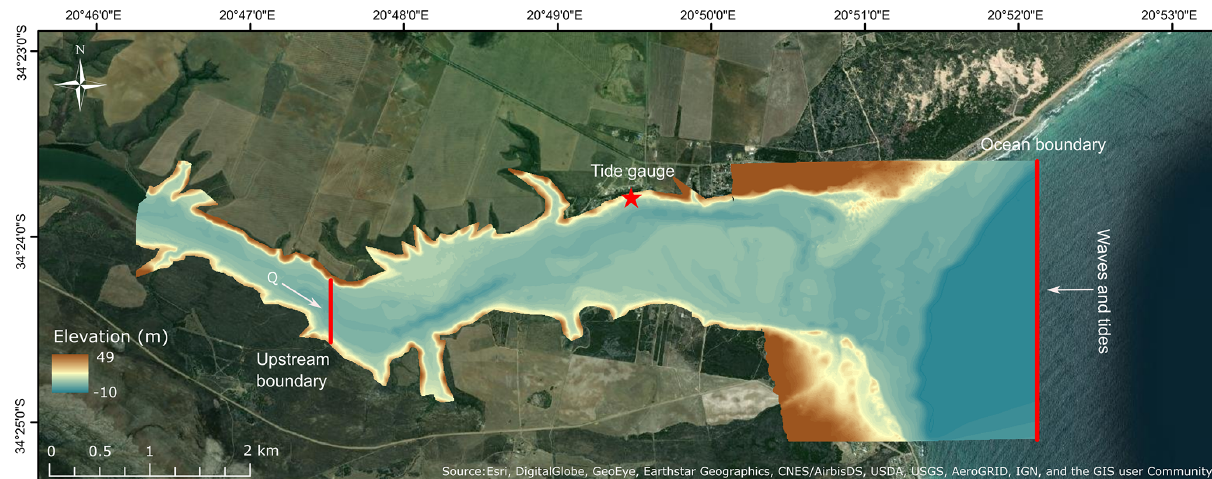
Figure 2. Model domain, including the merged bathymetry and elevation raster, the location of the Witsand tide gauge, and the two open